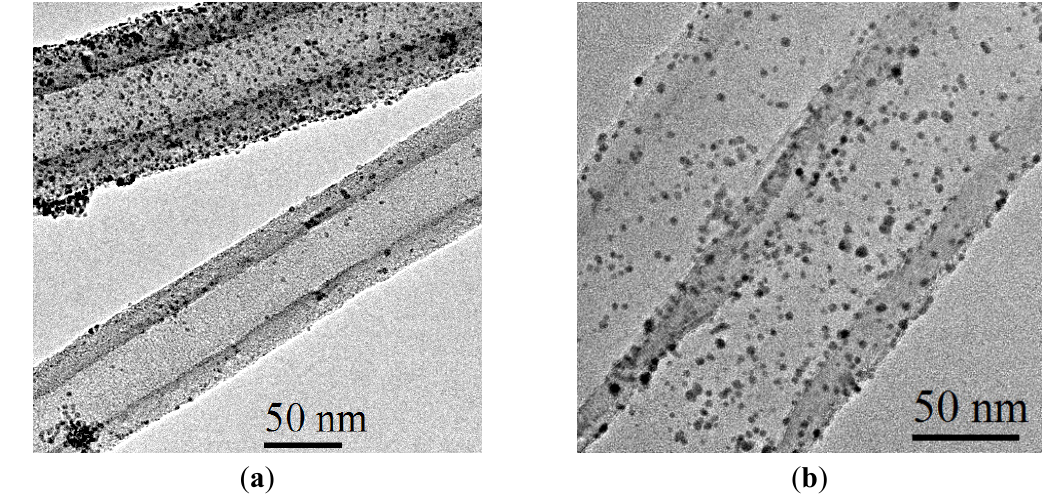
Figure 4. Influence of the support functionalities on immobilization of Au(PVA) sol.